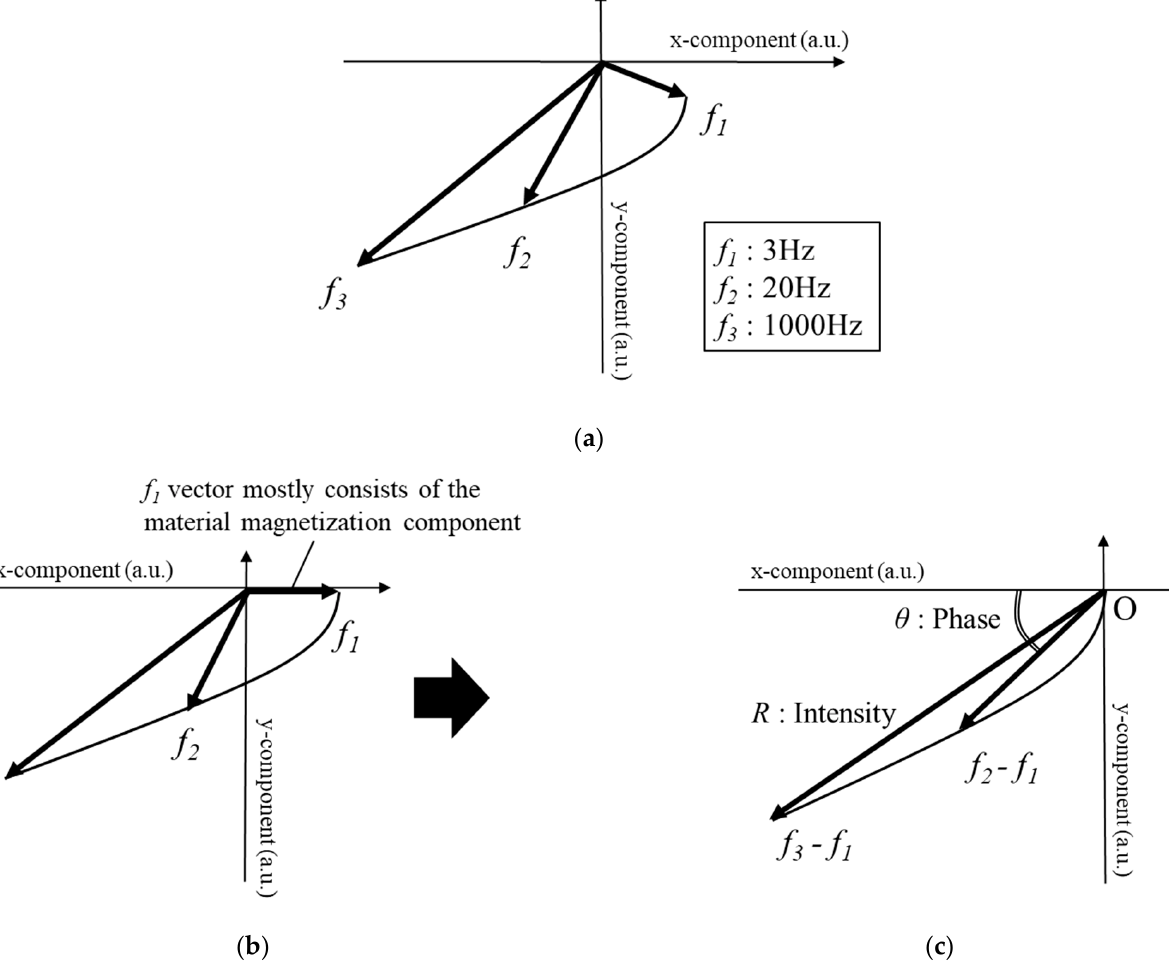
Figure 2. ( a ) Detected magnetic field vectors ( b ) Each vector after the residual magnetization component was subtracted ( c ) True magnetic field vector by eddy current.